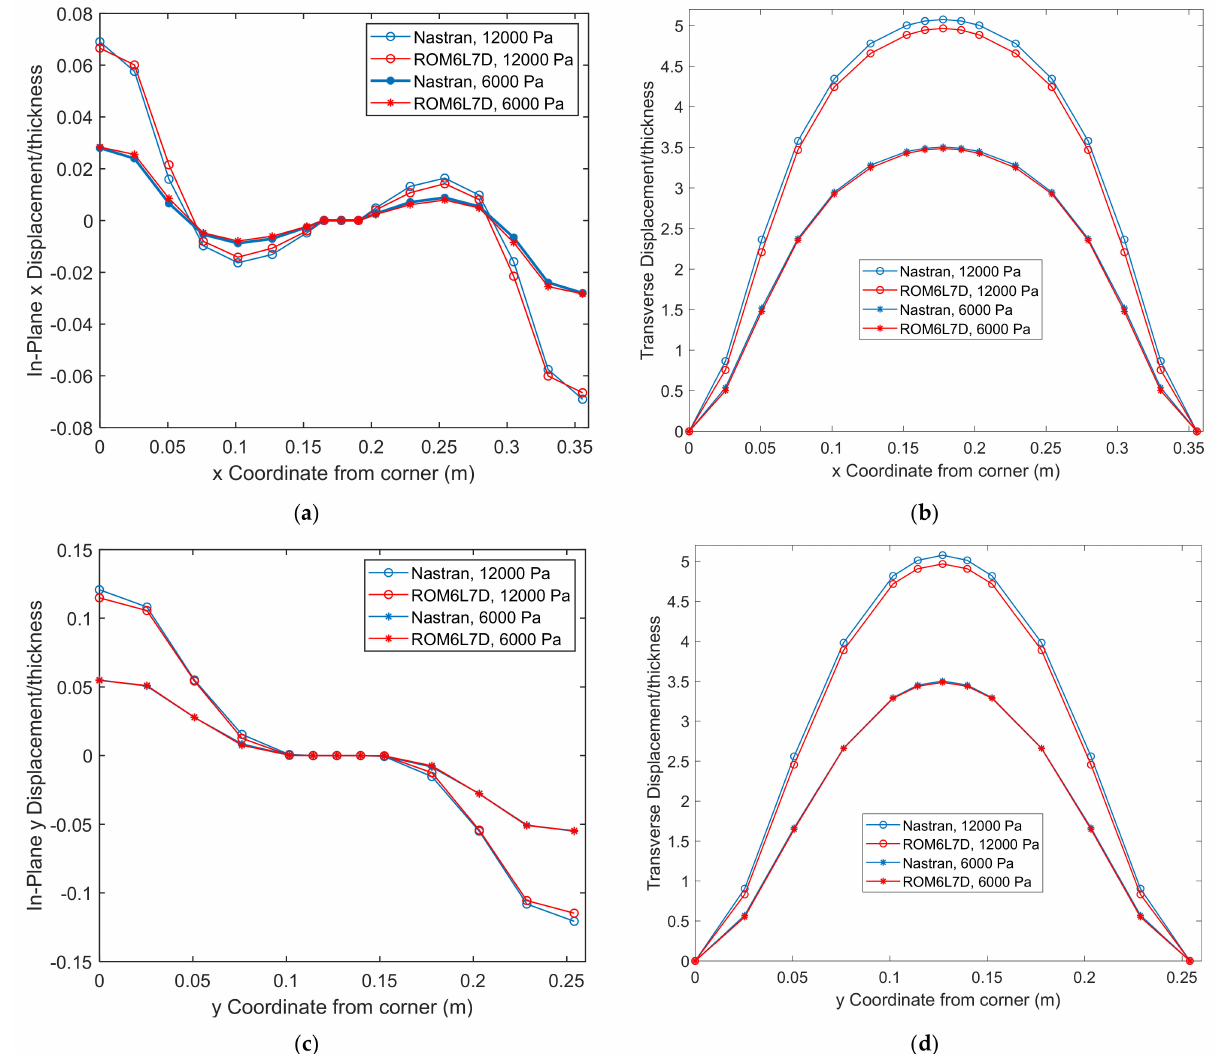
Figure 7. Displacements predicted by Nastran and the ROM 6L7D. Freely expanding plate, uniform pressures of 6000 and 12,000 Pa. Displacements of the nodes along the ( a , b ) middle y = 0 line in the ( a ) x (in-plane) and ( b ) z (transverse) directions, ( c , d ) middle x = 0 line in the ( c ) y (in-plane) and ( d ) z (transverse)